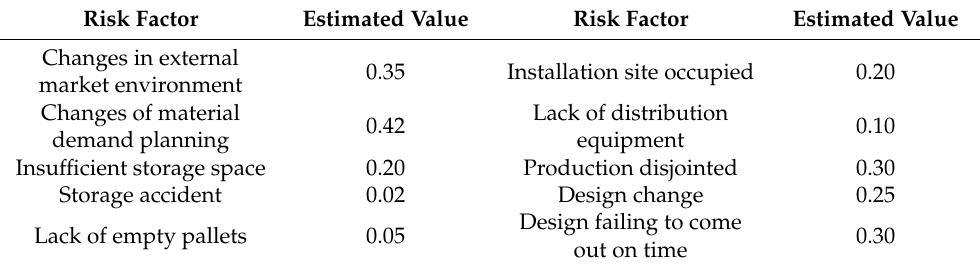
Table 2. Estimated values of risk